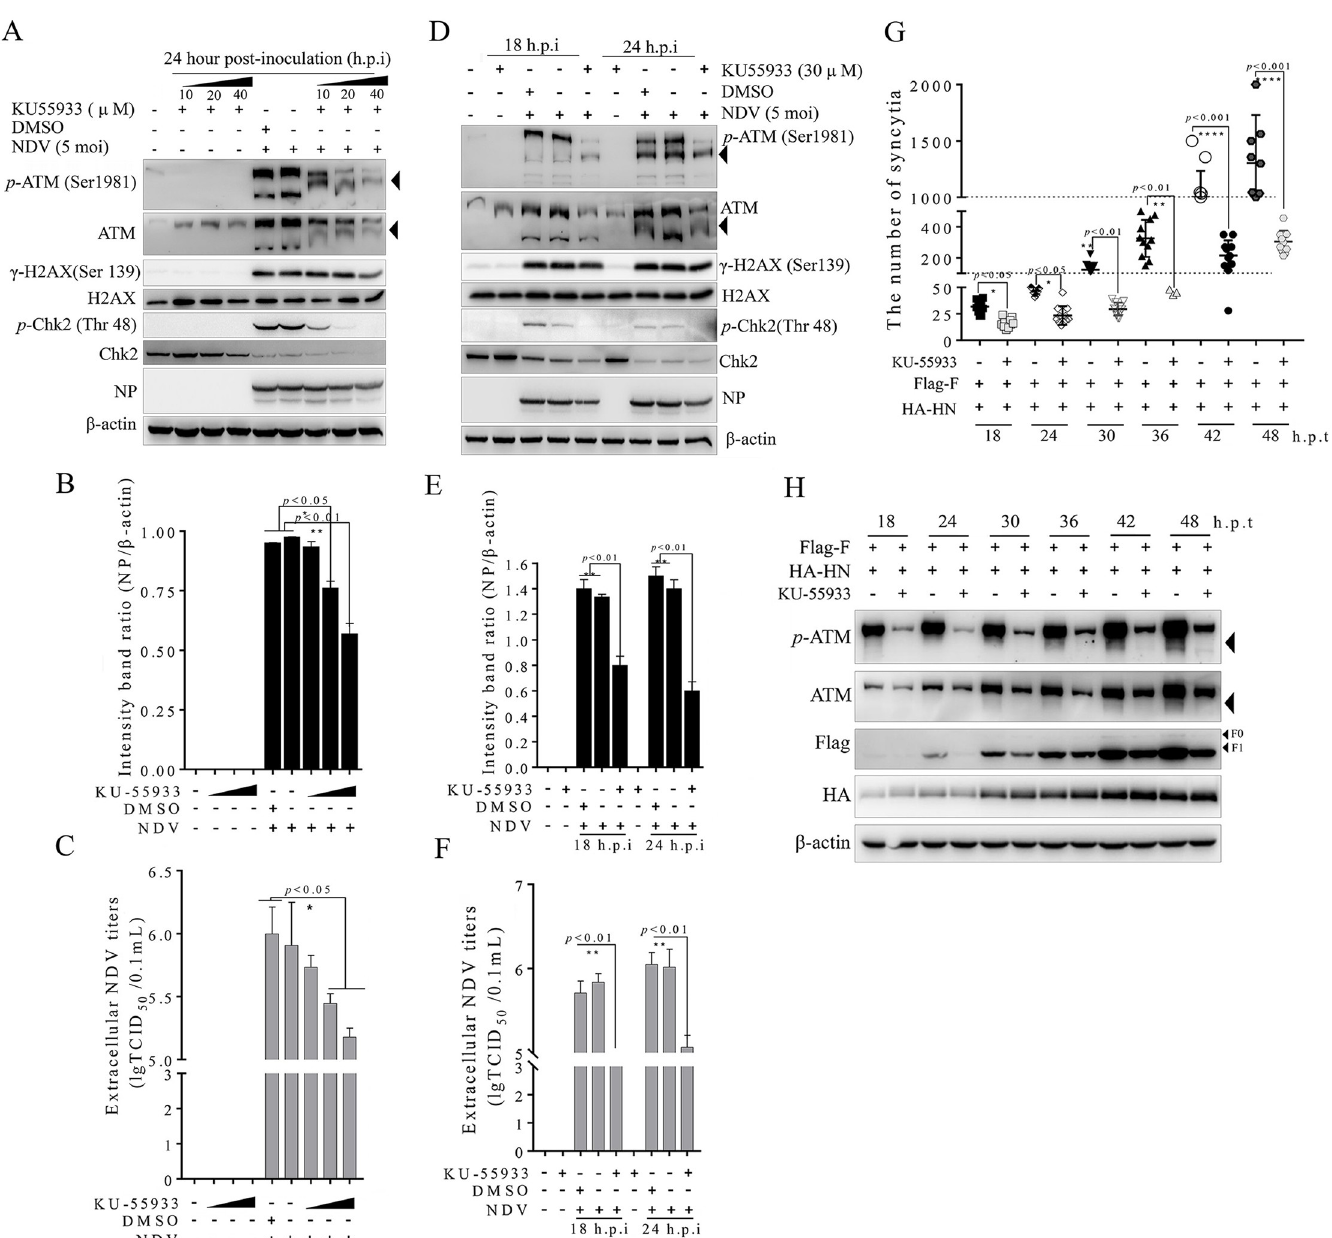
Fig 6. Inhibition of ATM kinase activity suppressed NDV replication and syncytium formation. (A) The ATM-dependent signaling pathway was required for NDV intracellular replication in a dose-dependent manner. A549 cells were pretreated at a working concentration of KU55933 at 10, 20, and 40 μ m for 1 h prior to NDV infection. A549 cells were mock-infected, NDV-infected (MOI = 5) for 24 h. At 24 h.p.i., Western blot samples were prepared and analyzed in accordance with the procedures in the Materials and Methods section. The monomer ATM was marked with a black triangle. β -actin served as a loading control. (B) The intensity band ratio of intracellular NDV NP to β -actin. Data were presented as means from three independent statistical experiments. The intensities of protein bands were quantified using Image J. Significance was analyzed using a one-tailed Student’s t-test. NS, p > 0.05; � , p < 0.05; �� , p < 0.01; ��� , p < 0.001. (C) The ATM-dependent signaling pathway was required for NDV extracellular replication in a dose-dependent manner. A549 cells were mock-infected, NDV-infected (MOI = 5) for 24 h. At 24 h.p.i., the cell- culture supernatants were collected and the extracellular NDV titers were determined on DF-1 cells as TCID 50 based on the Reed-Muench method. Significance was analyzed using a two-tailed Student’s t-test. NS, p > 0.05; � , p < 0.05; �� , p < 0.01; ��� , p < 0.001. (D) The ATM-dependent signaling pathway was required for NDV intracellular replication in a time-dependent manner. A549 cells were pretreated at a working concentration of KU55933 at 30 μ m for 1 h prior to NDV infection. A549 cells were mock-infected and NDV-infected (MOI = 5) for 18 and 24 h. At 18 and 24 h.p.i., Western blot samples were prepared and analyzed. (E) The intensity band ratio of intracellular NDV NP to β -actin. The intensities of protein bands were quantified using Image J. (F) The ATM-dependent signaling pathway was required for NDV extracellular replication in a time-dependent manner. A549 cells were mock-infected and NDV-infected (MOI = 5) for 18 h and 24 h. At 18 and 24 h.p.i., the cell- culture supernatants were collected and the extracellular NDV titers were determined. (G) Statistical analysis of the effect of ATM inhibitor KU55933 on syncytium